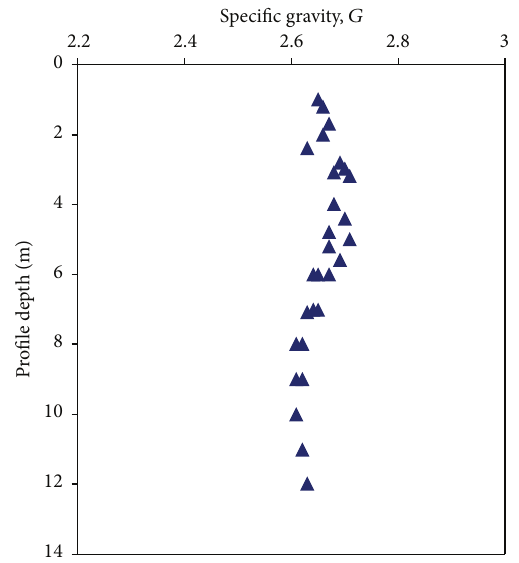
Figure 4: Standard proctor compaction test curve for granular